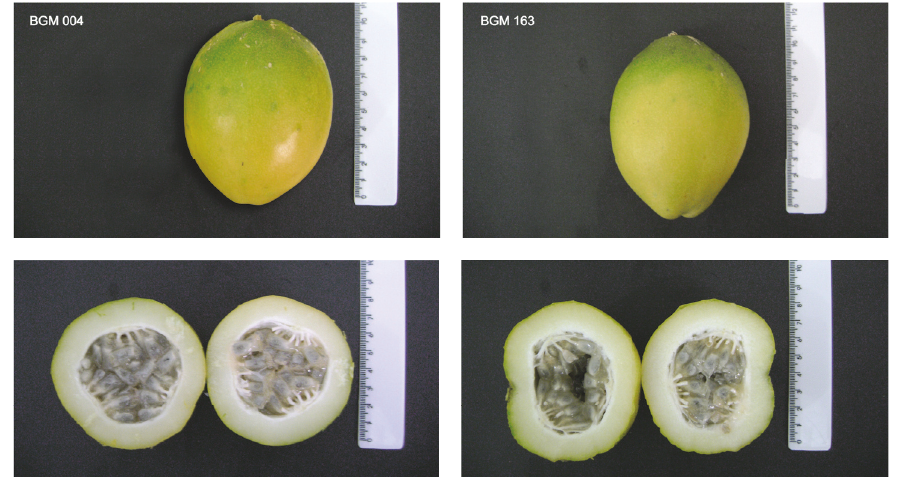
Figure 1: Passiflora alata Curtis (sweet passion fruit) genotypes harvested when about 75% of the peel became yellow (75% ripe).